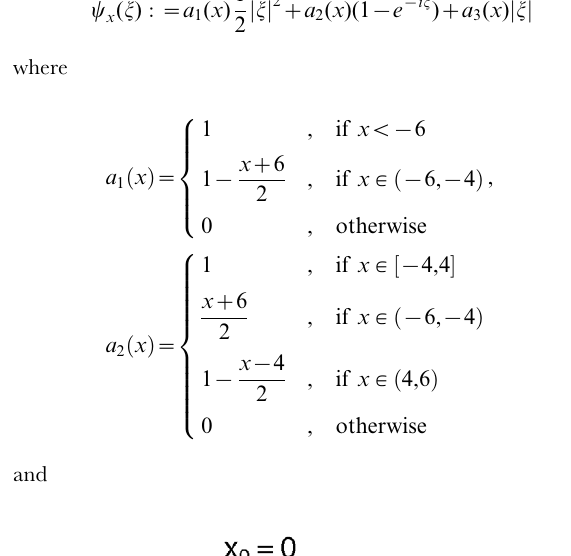
(cid:5) (cid:6)(cid:5) (cid:6) (cid:5) (cid:6) 19 x x { x { x . Each position is color coded by the corresponding value of the ^ 10 4 4 4 4